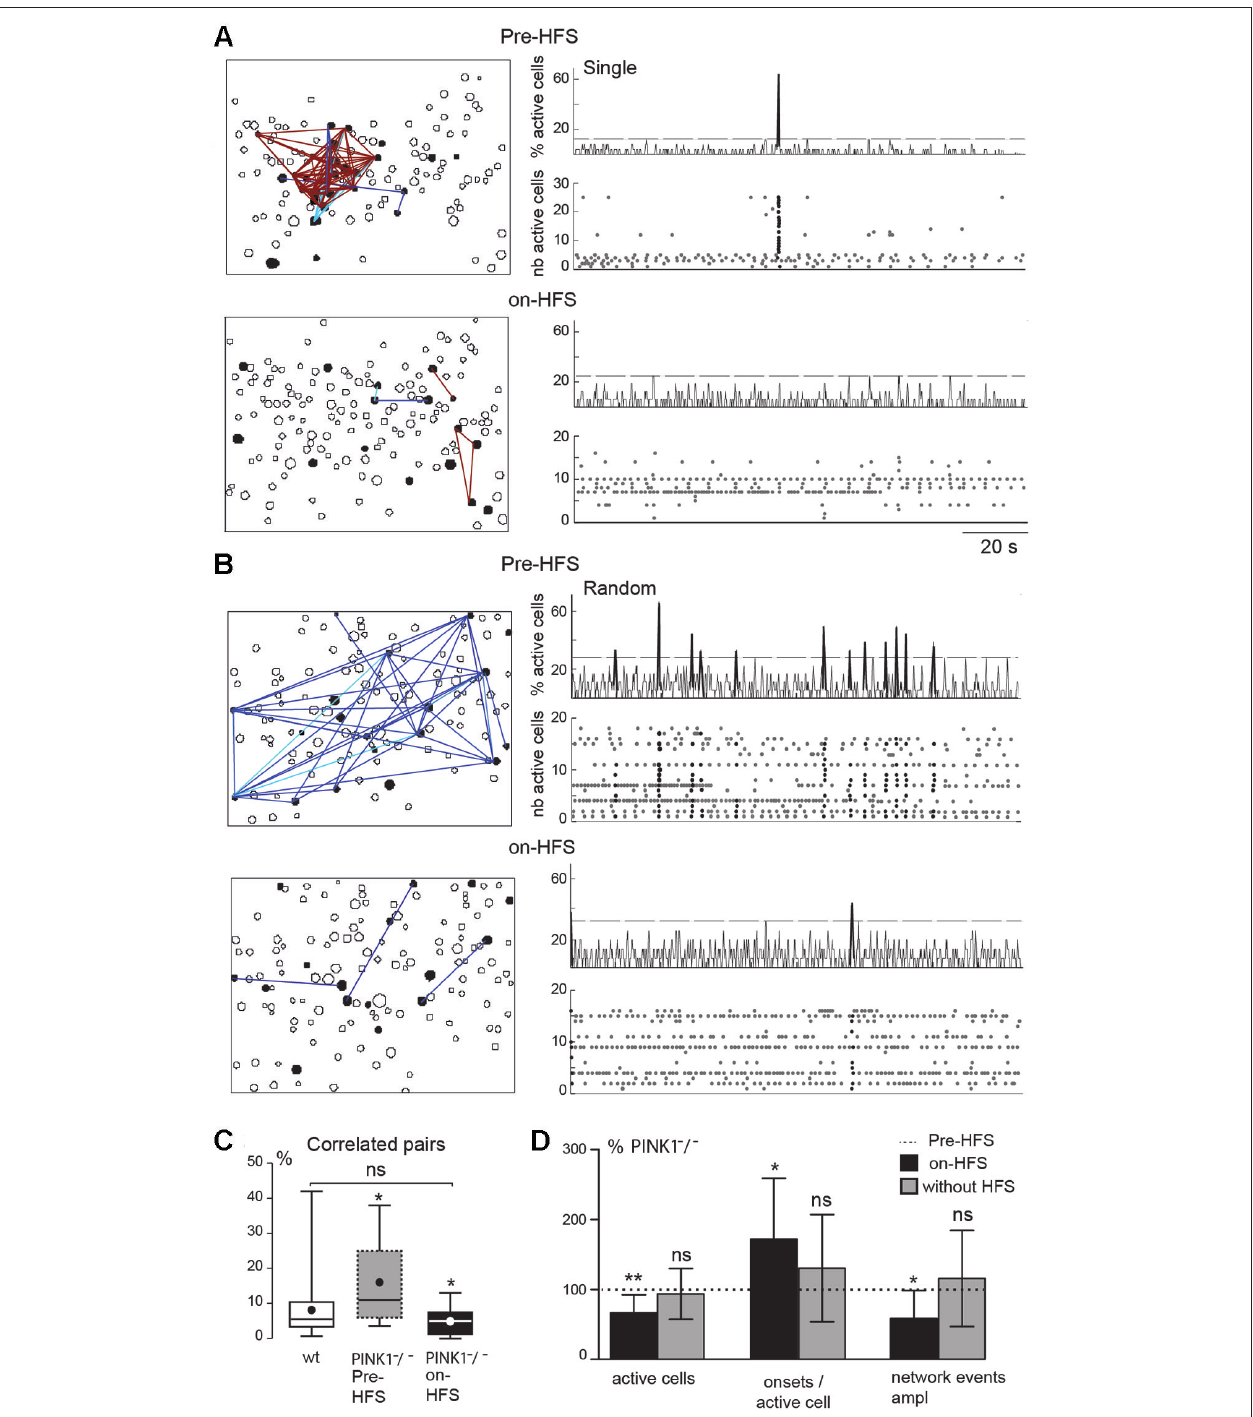
( B , Pre-HFS) (total recording 137 s). (C) Percentage of correlated cell pairs compared to all combinations of fura2-loaded cells (active and non-active) in wt ( n = 35) or PINK1 − / − M1 ( n = 9) fields before and during HFS as indicated. (D) From left to right, percentage of active cells, onsets per active cells, network event amplitude in M1 fields after 3 min HFS (black, n = 9 PINK1 − / − M1 fields) or after 3 min without HFS (gray, n = 27 PINK1 − / − M1 fields), compared to the same items before HFS (normalized at 100%, dotted